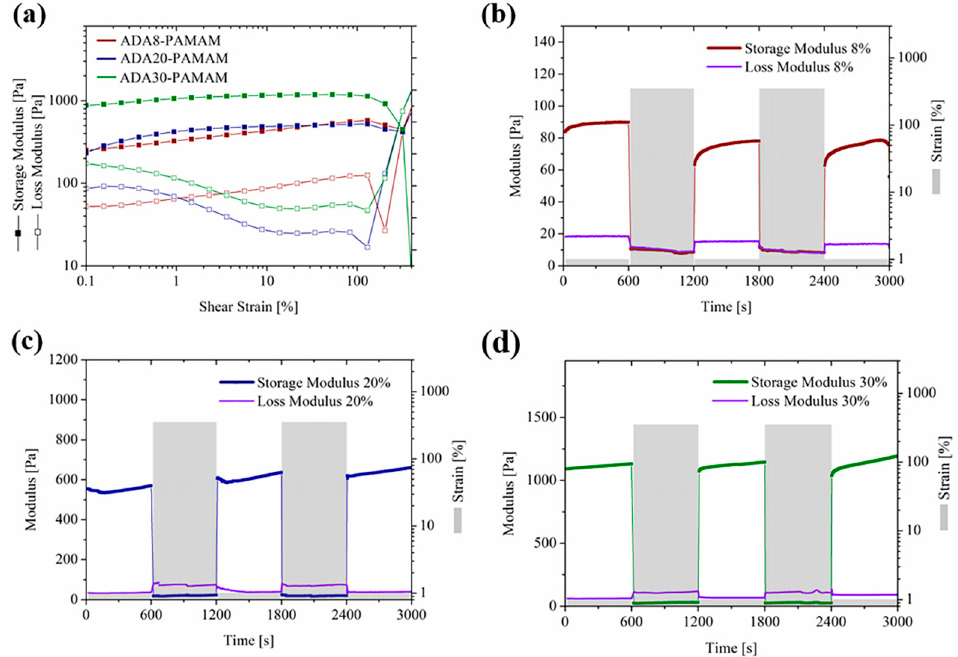
Figure 6. Results of cyclic stress test. ( a ) Amplitude sweep results. Cyclic stress test results of ( b ) ADA8-PAMAM, ( c ) ADA20-PAMAM and ( d ) ADA30-PAMAM are presented,